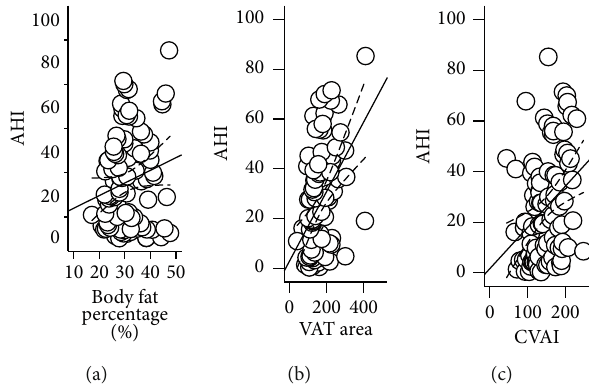
Figure 2: The correlation of AHI with body fat percentage, VAT area, and CVAI.